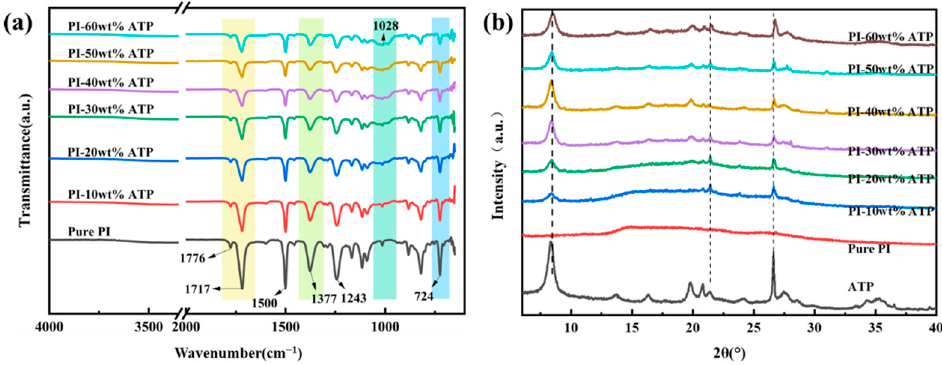
Figure 3. ( a )ATR-FTIR curves and ( b ) XRD curves of pure PI and ATP / PI composite membranes. Figure 3. ( a ) ATR-FTIR curves and ( b ) XRD curves of pure PI and ATP / PI composite